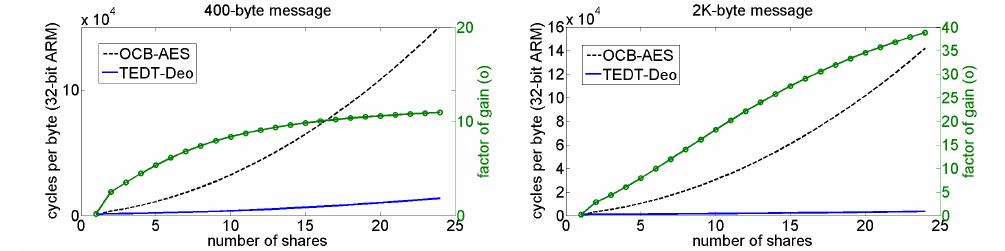
Figure 10: Performance estimations (II): uniformly masked implementation of OCB based on the AES versus leveled implementation of TEDT based on Deoxys-BC-256